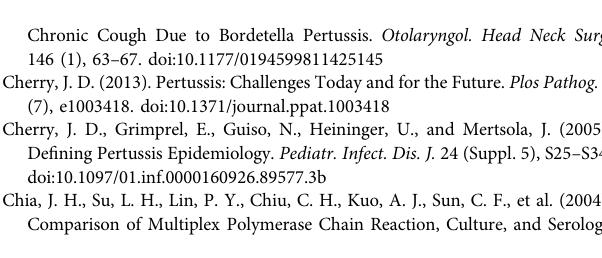
Frontiers in Bioengineering and Biotechnology |